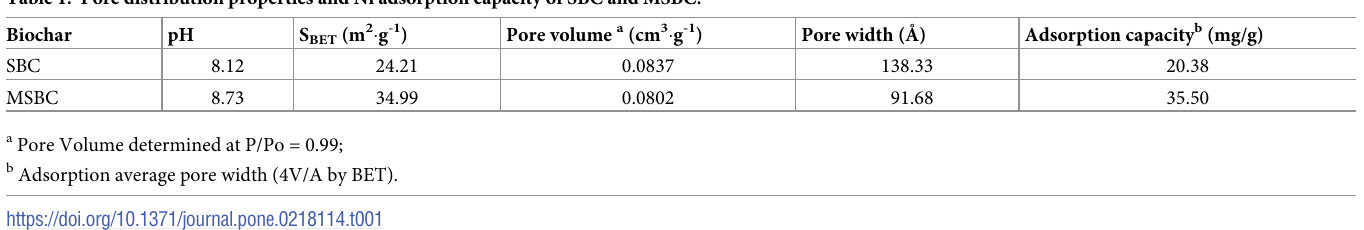
(Table 1). The reduction of the pore volume and pore width during the fabrication of MSBC could be attributed to the occupation of iron compounds into the pores of the biochar. The XRD patterns of crystalline structures and composition of SBC and MSBC are shown in S1 Fig. Sharp reflection peaks at 20.86˚, 26.30˚, 36.55˚, 42.14˚, 50.15˚, 60.00˚ and 68.08˚ in SBC and MSBC could be indexed as the planes of SiO (PDF#65–0466), which were in line 2 with the data in a previous study [29]. Therefore, SiO could be reasonably considered as the 2 dominating crystalline phase in both of SBC and MSBC. Furthermore, several peaks at 27.91˚, 34.79˚, 39.12˚, 40.25˚, 45.90˚, 54.95˚ and 19.80˚, 36.50˚, 55.80˚, 60.00˚ for MSBC revealed the formation of α -Fe O (PDF#16–0653) and α -FeOOH (PDF#26–0792), respectively. The for- 2 3 mation processes could be described by reactions (1)–(5). These reactions were confirmed by a previous study by Xiong and Zhou [30]. It has been demonstrated that Fe(OH) can produce 3 the mixture of FeOOH and α -Fe O at the range of 40–80 ˚C, but only α -Fe O at above 80˚C 2 3 2 3 [30]. The drying temperature was set at 70˚C in this study, which could probably explain the observed crystalline phases.